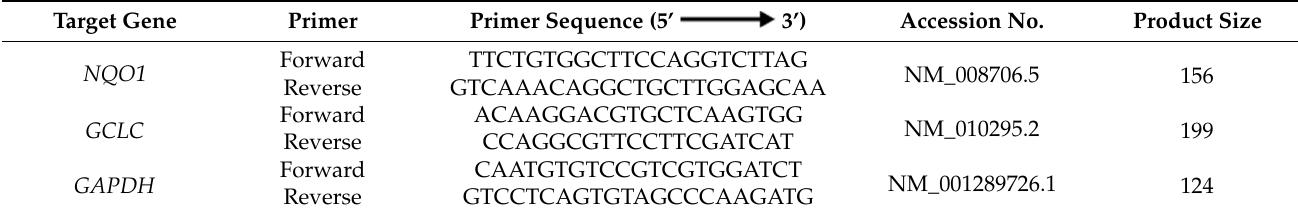
Table 3. Cont. Table 3. Sequences of primers used in